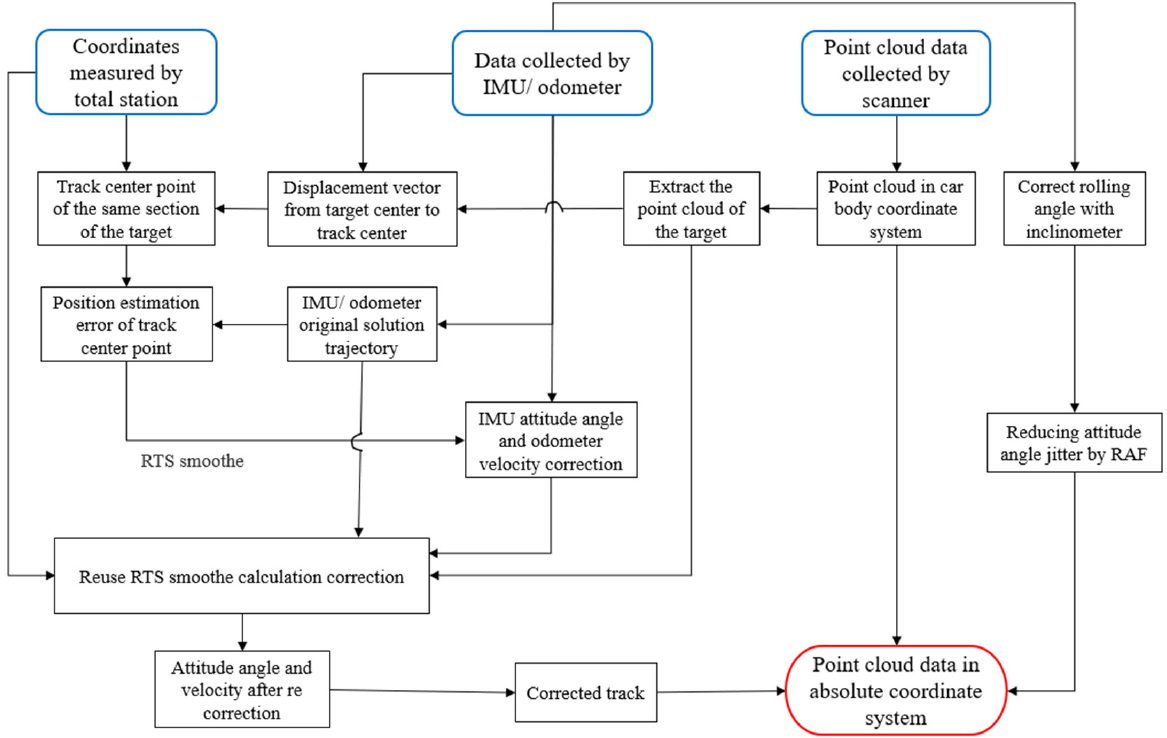
Figure 2. Flow chart of point cloud generation based on RTS filtering and smoothing.